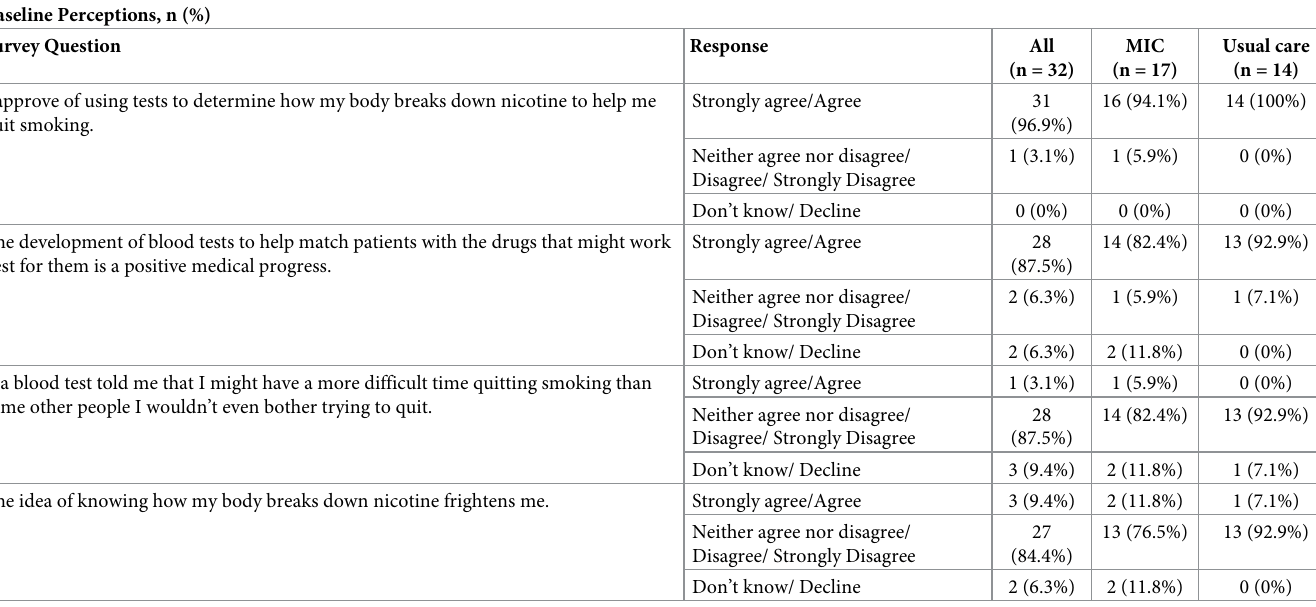
Table 4. Participant baseline perceptions about metabolism informed